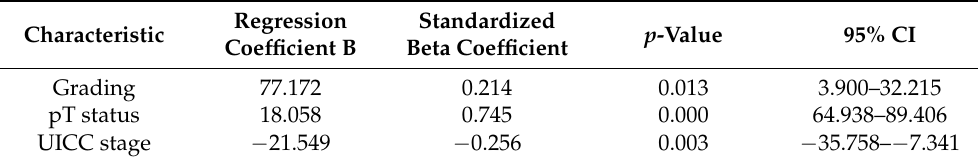
Table 3. Multivariate analysis of EZH2-associated characteristics. UICC: Union international contre le